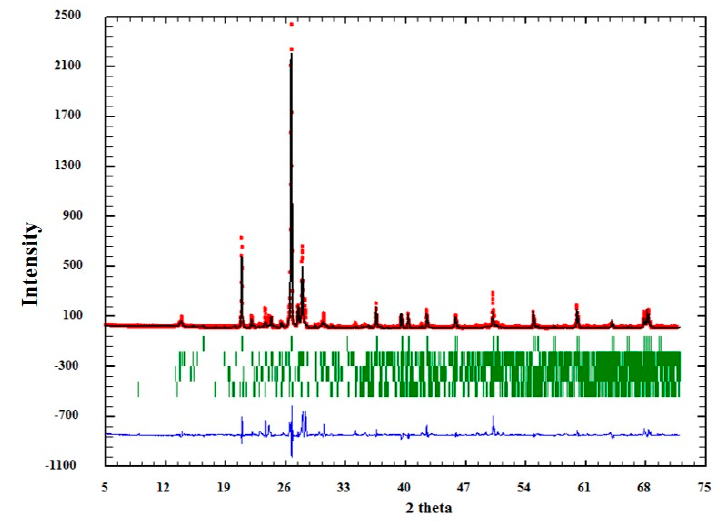
Figure 6. Adjustment through the Rietveld refinement of sample QM3.